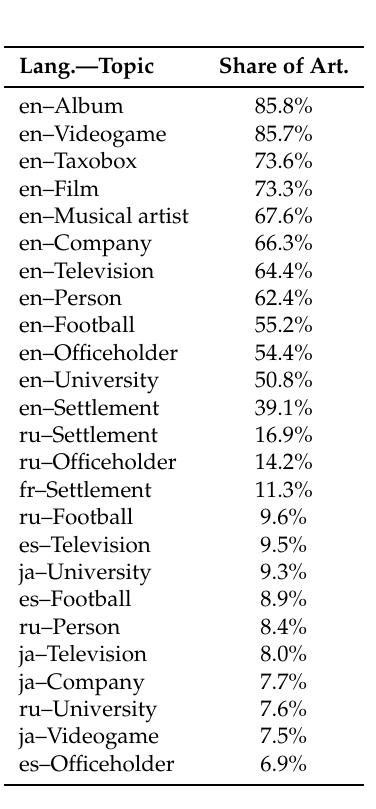
Table 10. Top 25 language versions and topics with share of articles that have the highest popularity in comparison to other languages (articles with at least three language versions were considered). Source: own